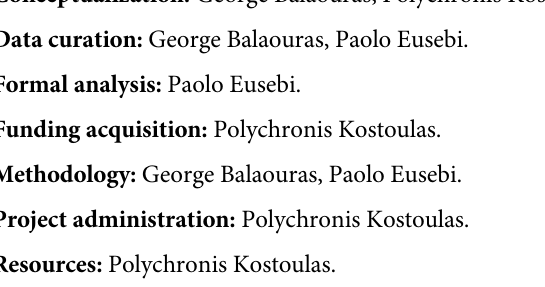
S2 Table. Leave-one-out method results for Rhesus.